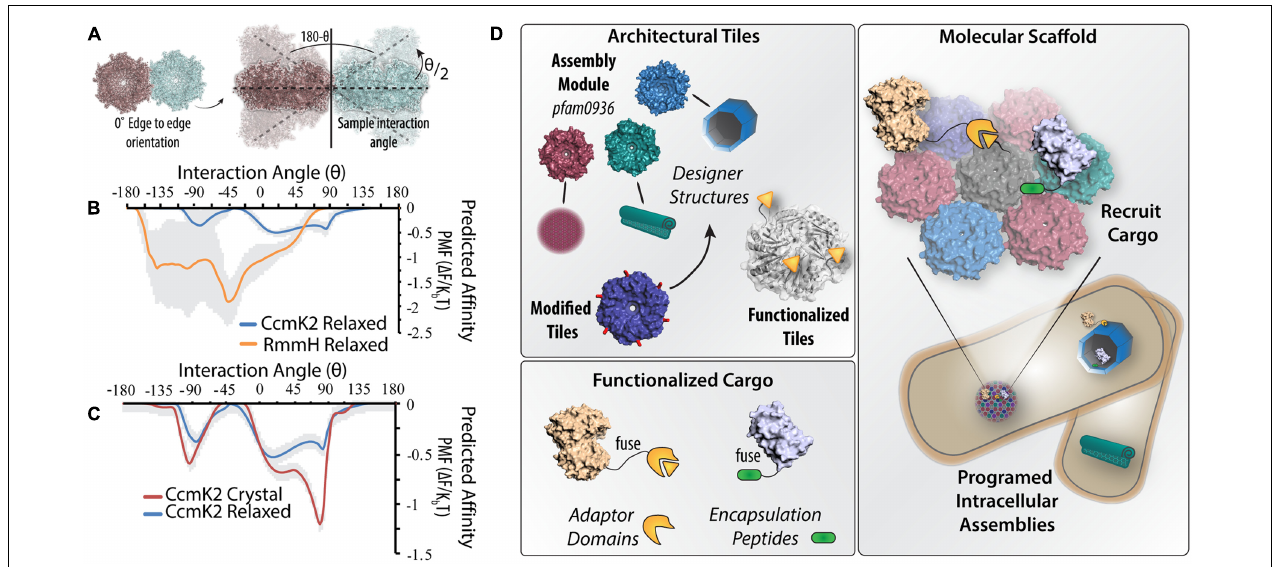
FIGURE 2 | Could molecular-level simulations contribute toward predictive assembly of diverse BMC-H scaffolds? (A) Illustration of design of molecular dynamics simulations where the potential of mean force (PMF) is calculated from two adjacent hexamers. Keeping the relative orientation fixed, the hexamers are systematically rotated out of the plane by an angle θ /2 and the change in PMF is recalculated. (B) Differences in the predicted PMF depending on the inter-hexamer angle are shown for solvated crystal structures of RmmH and CcmK2 (standard deviation between simulations is depicted in gray). (C) Differences in the angular PMF profile can solely arise by comparing the crystal structure versus solvated structure. (D) Illustration of pipeline for constructing BMC-H based programmable nanostructures. BMC-H proteins with different assembly characteristics can be selected from existing homologs (magenta, green, and blue) or created by modification of key residues (red) and modified to encode protein interaction domains (orange). Enzymes and other cargo can be directed to BMC-H assemblies by fusing corresponding ligand domains, or the use of native encapsulation peptides (green). In this manner, it is feasible to envision a diversity of subcellular protein architectures that can be functionalized to scaffold many distinct metabolic or signaling